Question: Which visualization type does this figure use?
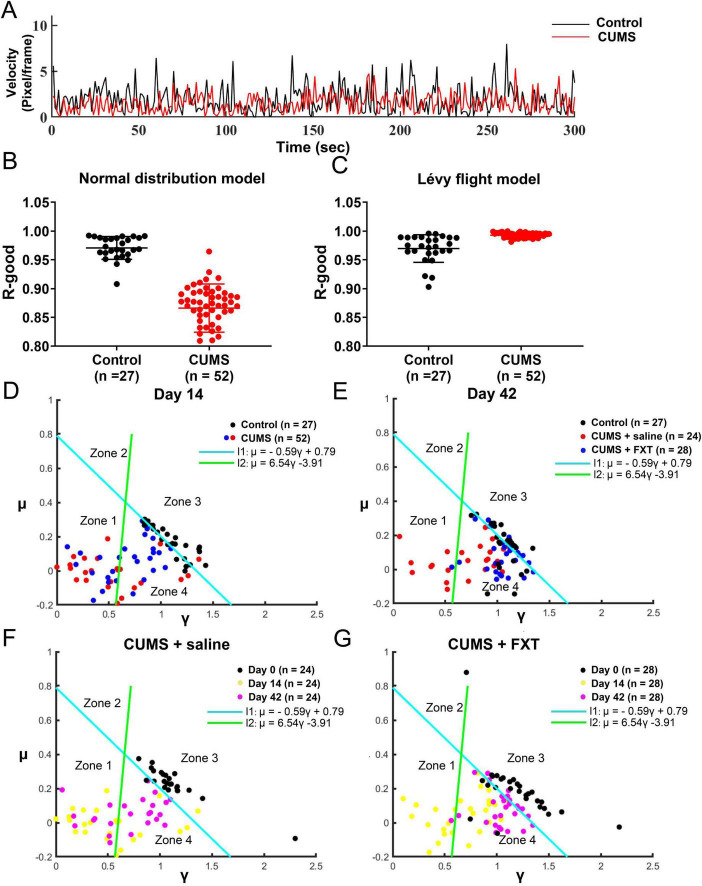
Answer: line